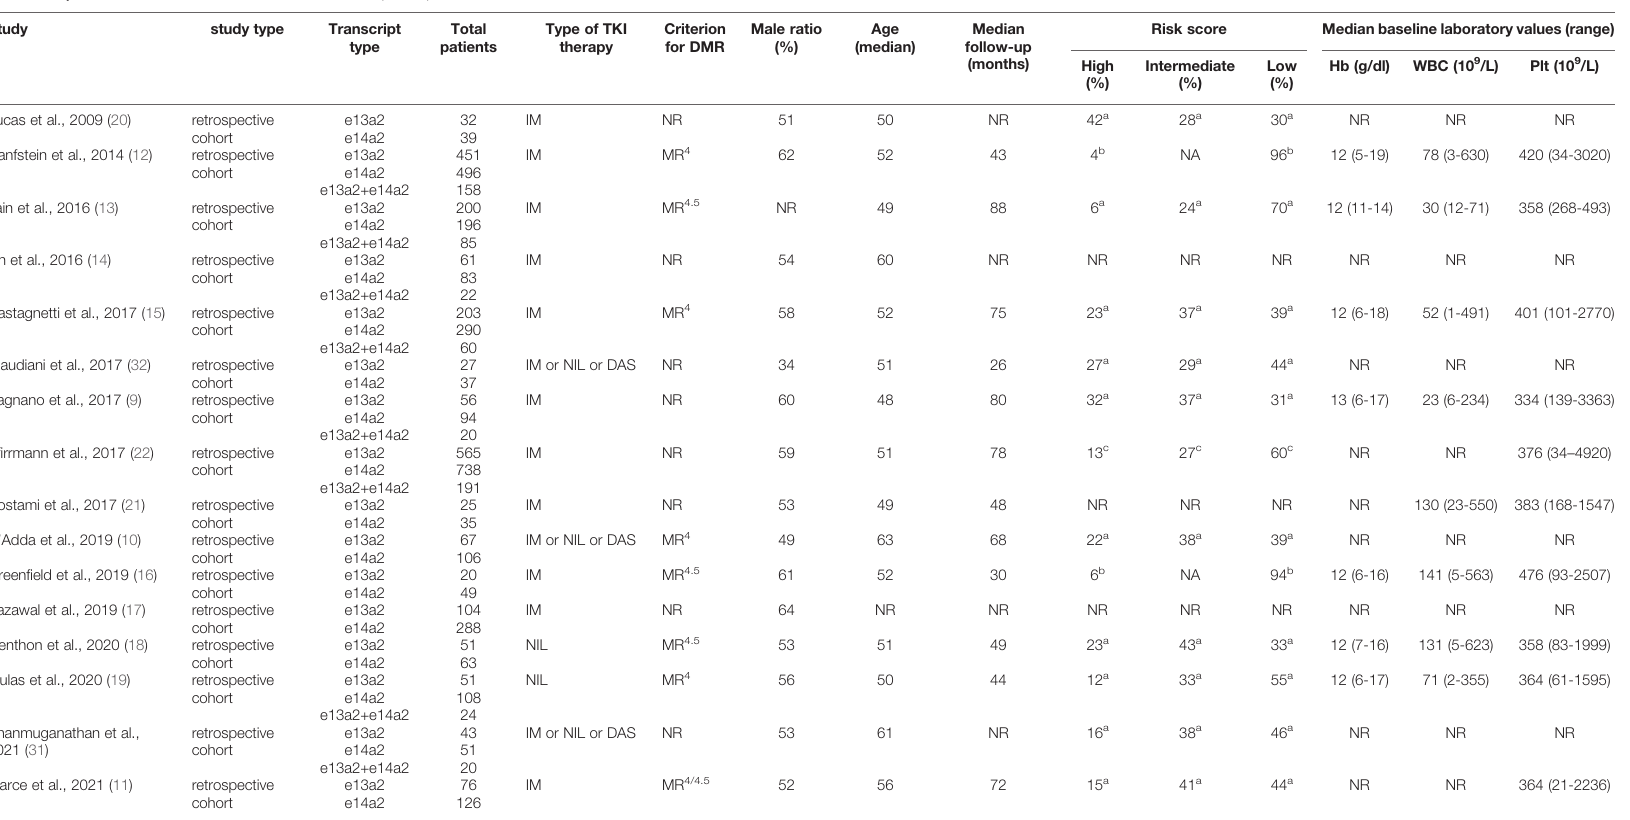
TABLE 1 | Characteristics of the included trials and participants. Study